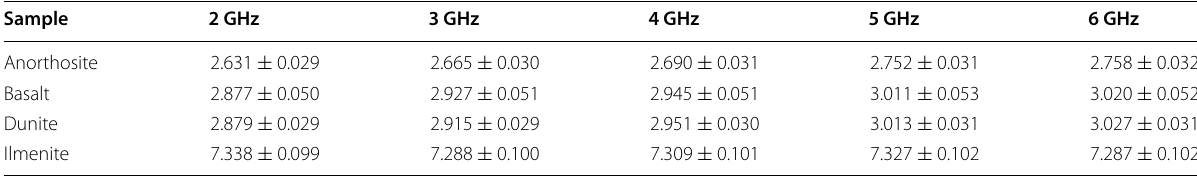
The value shows the average of 5 points below and 5 points above each frequency (e.g., the average of the permittivity from 1.984–2.018 GHz in the case of 2 GHz) In the case of 6 GHz, it is averaged with the 10 points only below the frequency (i.e., the average of the permittivity from 5.966 to 6.000